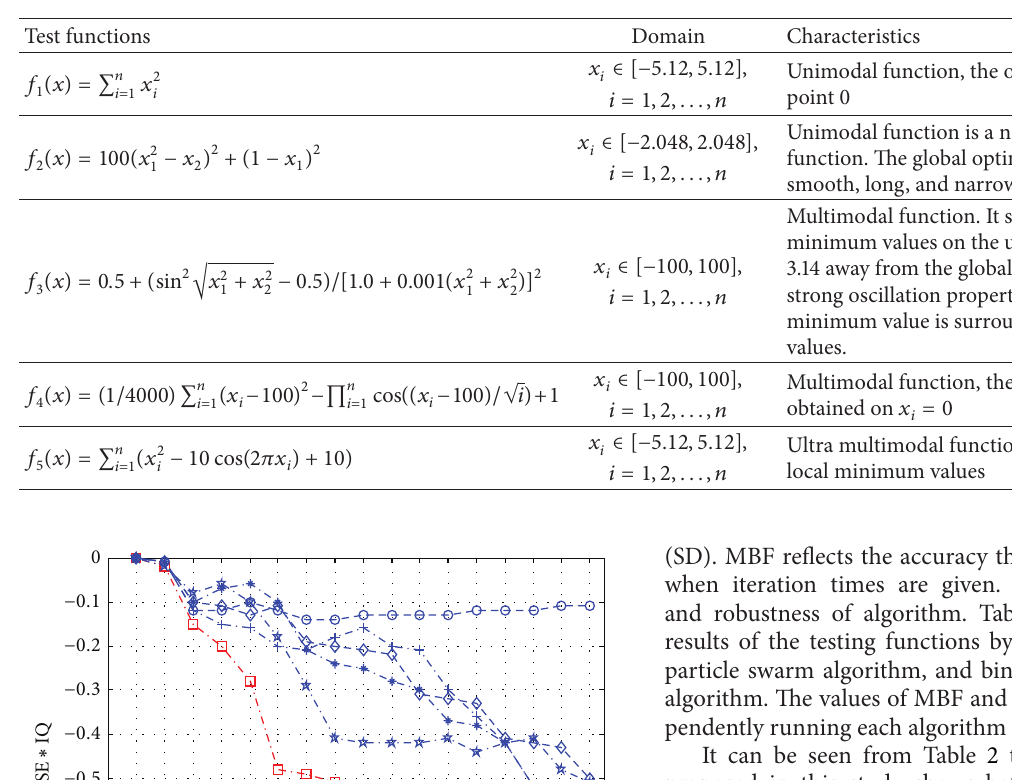
Table 1: The test functions.